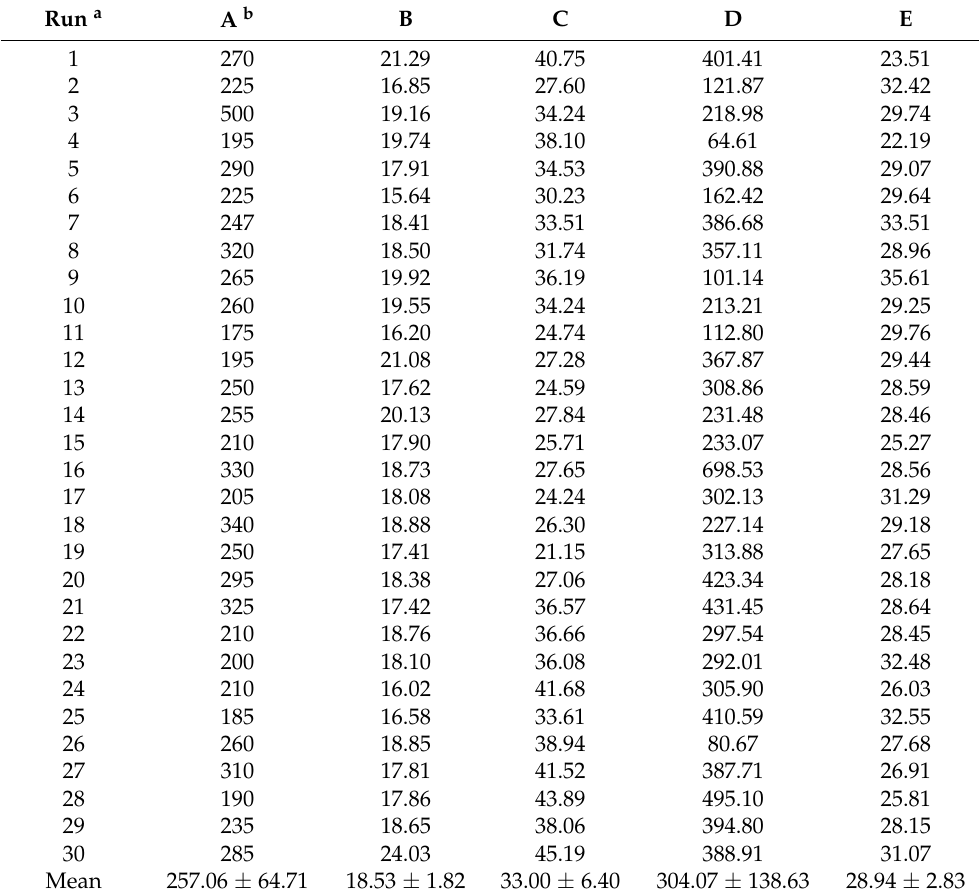
Table 3. Dependent variables used in optimization; drying time, total phenolics, antioxidant capacity (ABTS), ascorbic acid, and h ◦ of dried strawberries with CM pre-treatment. Run a A b